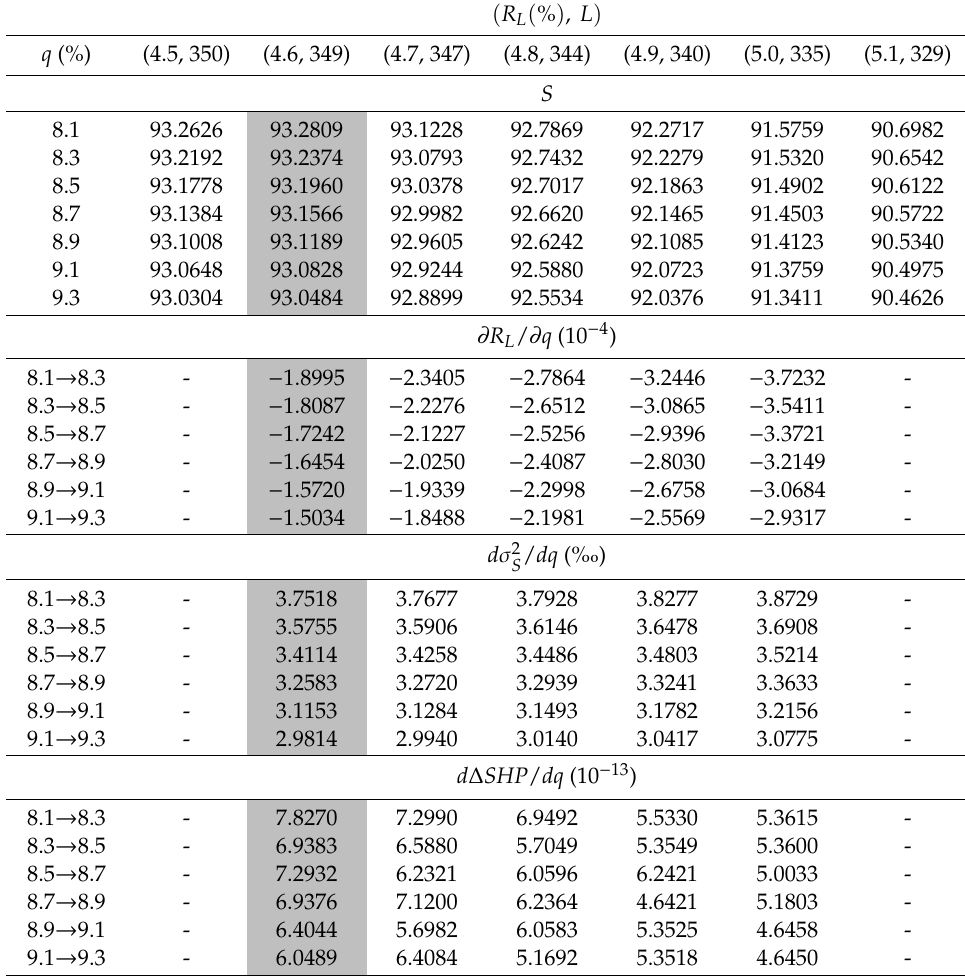
Table 7. E ff ects of capital-to-deposits ratio on domestic loan rate, equity risk, and diversification e ffi ciency.